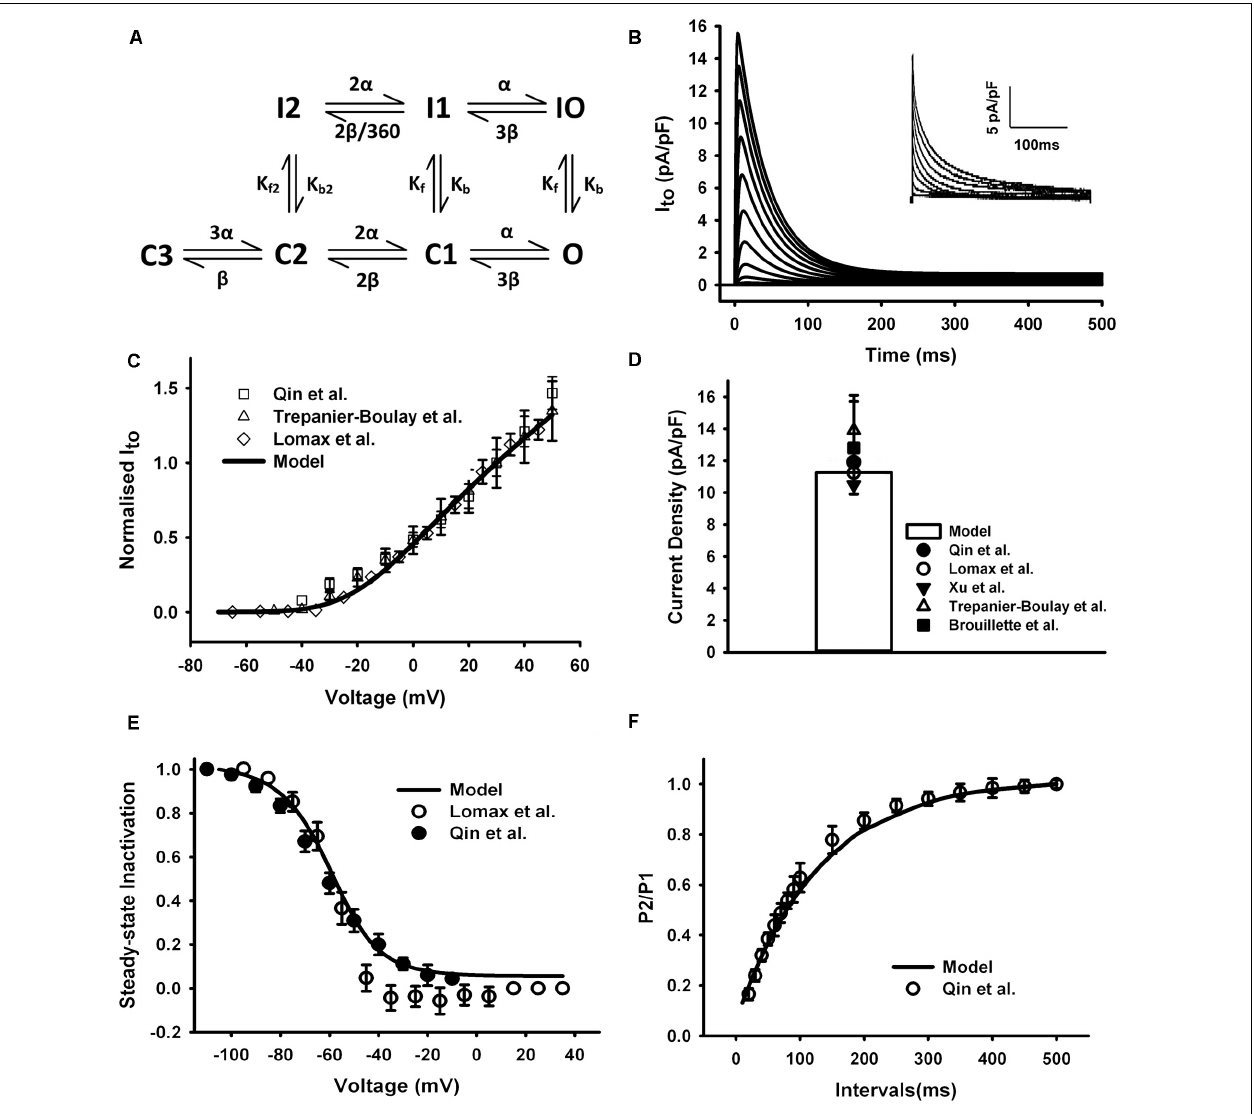
FIGURE 3 | I to in the atrial myocyte model and comparison with experimental data. (A) Schematic diagram of seven-state Markov chain model of I to (Campbell et al., 1993). (B) Current traces for the corresponding voltage clamp protocol. The inset shows the experimental record. (C) I–V relationship, current normalized to its amplitude at +30 mV. (D) Current density at +30 mV. (E) Steady-state inactivation curve. (F) Recovery curve from inactivation. (Experimental data: Lomax et al., 2003a; Trépanier-Boulay et al., 2004; Qin et al.,